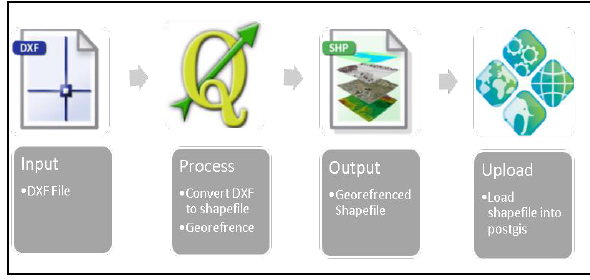
Figure 4. Process diagram of data transformation